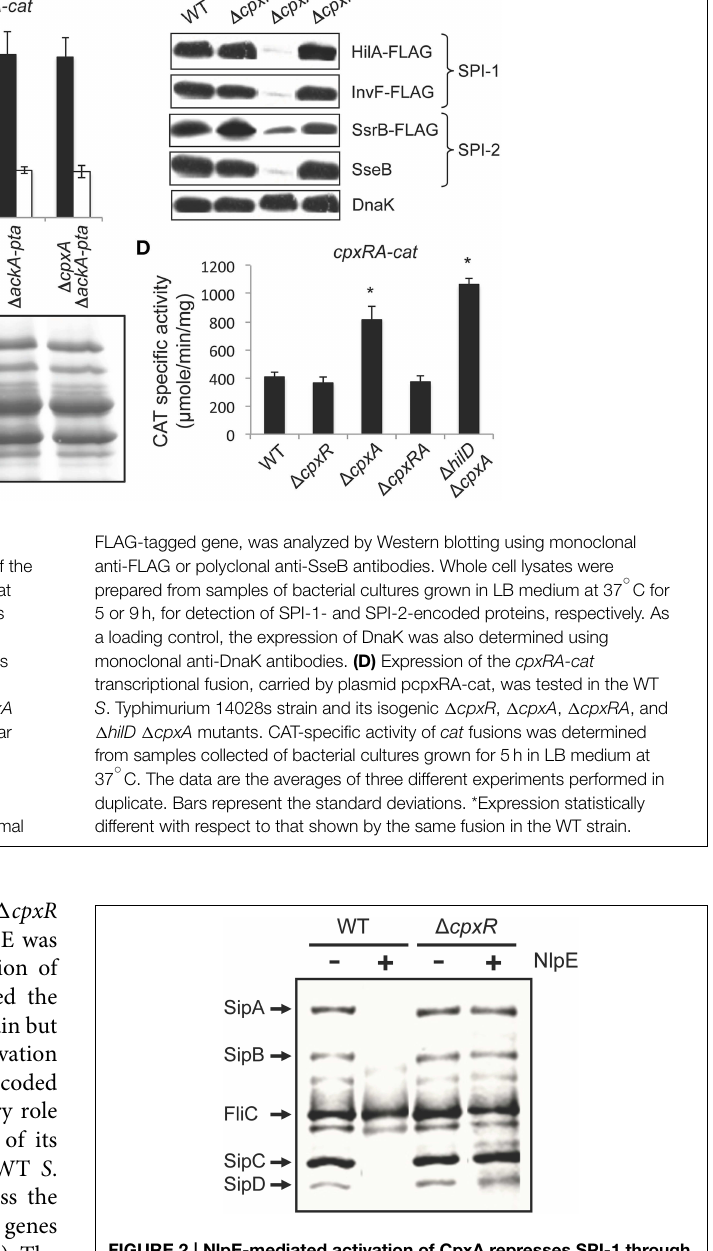
FIGURE 2 | NlpE-mediated activation of CpxA represses SPI-1 through CpxR. Secretion analysis of the SPI-1-encoded proteins SipA, SipB, SipC, and SipD was tested in the WT S . Typhimurium strain and its isogenic 1 cpxR mutant carrying plasmid pCA-NlpE, grown for 9h in LB medium at 37 ◦ C. FliC is a flagellar protein whose secretion is SPI-1-independent. Expression ( + ) of NlpE from the T5-lac promoter of plasmid pCA-NlpE was induced by adding 50 µ M IPTG at the beginning of the bacterial